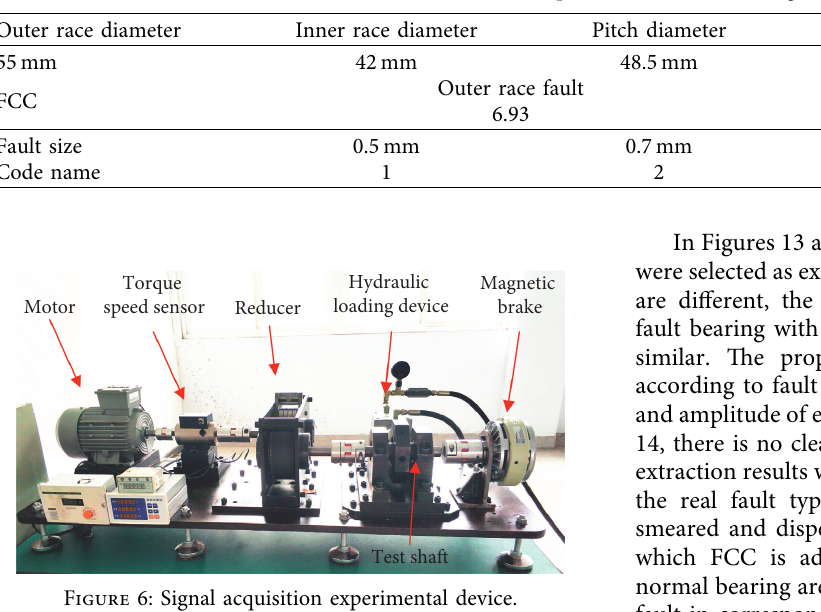
Table 1: Basic parameters of test bearings.